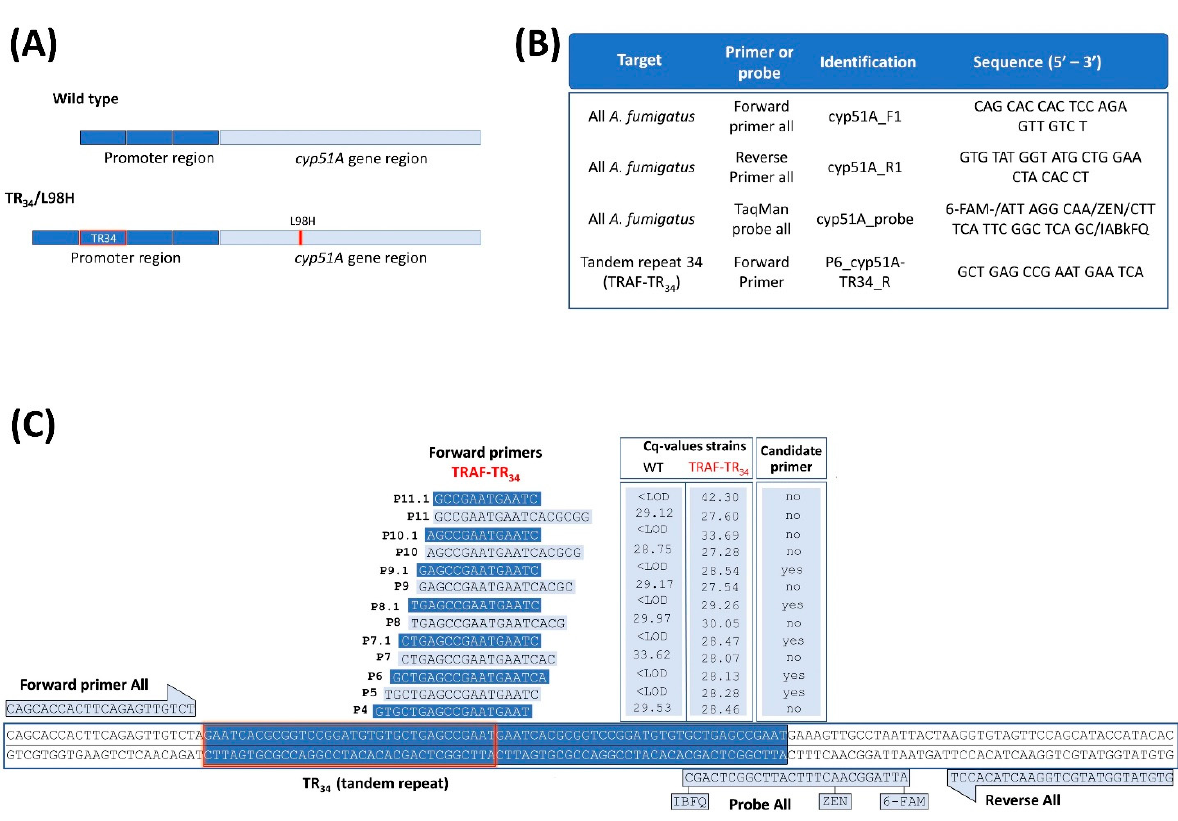
Figure 1. Quantitative PCR assay targeted to the detection of the single cyp51A copy gene and the mutated tandem repeat 34 (TR 34 ). ( A ) Schematic comparison of the cyp51A gene and its promoter region of a WT and a triazole-resistant A. fumigatus harboring a TR 34 /L98H cyp51A gene mutation (TRAF-TR 34 ). ( B ) Selected PCR primers and probe sequences for our qPCR assay targeted to detect the single cyp51A copy gene in all A. fumigatus strains and strains with mutated TR 34 . ( C ) Oligonucleotide sequences and primer map locations of 13 forward primers targeted to the tandem repeat 34-region of TRAF-TR 34 strains. Cq reaction values and their specificity for TR 34 detection are depicted in the graphic table on the right (1 × 10 6 WT and TRAF-TR 34 conidia). Candidate primers for mutant detection were selected if they amplified the mutant TRAF-TR 34 (Cq ± 28) without amplifying the WT (<LOD). Abbreviations: quantification cycle (Cq), below limit of detection (<LOD), wild-